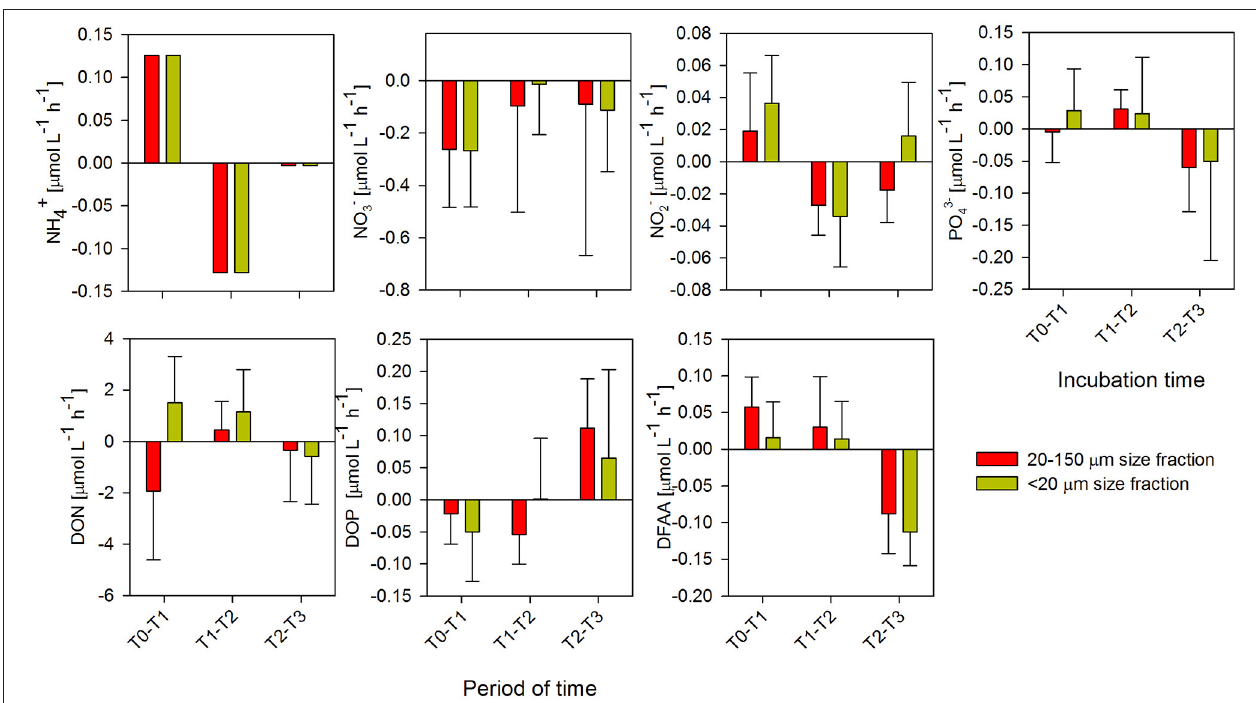
FIGURE 4 | Turnover rates of ammonium (NH + 4 ), nitrate (NO − 3 ), nitrite (NO − 2 ), phosphate (PO 3 − 4 ), dissolved organic nitrogen (DON), dissolved organic phosphorus (DOP), and dissolved free amino acids (DFAAs) estimated for every 2h of incubation, during the microbial response phase in spring. Each point represents four replicates (mean ± standard